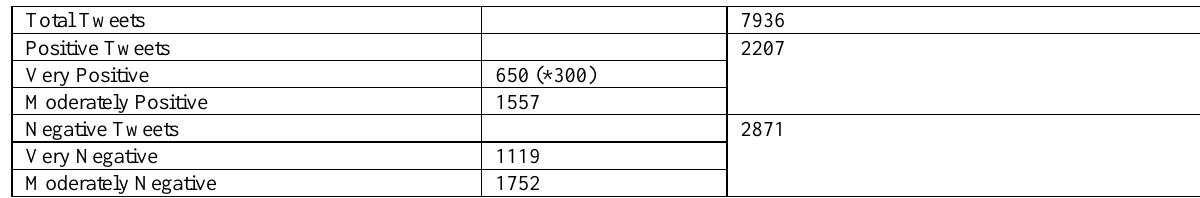
Table 4. Sentiment